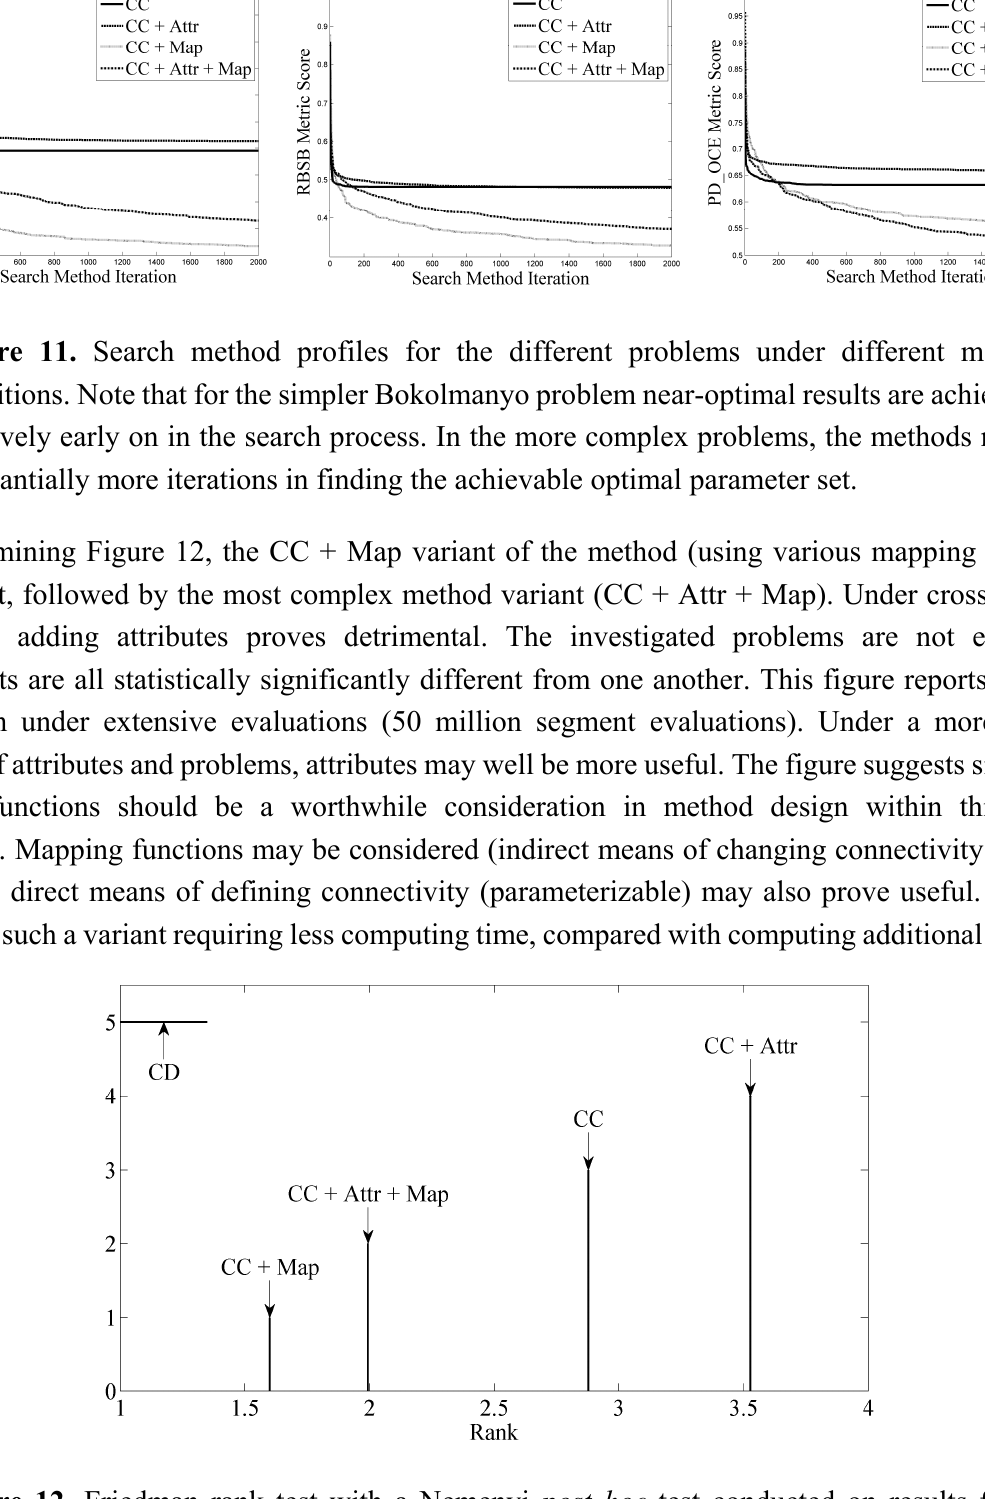
Figure 12. Friedman rank test with a Nemenyi post hoc test conducted on results from Tables 8–10. Confidence interval is set to 95%. A Critical Difference (CD) of 0.349 is generated (ranking). All method variants deliver statistically significant different